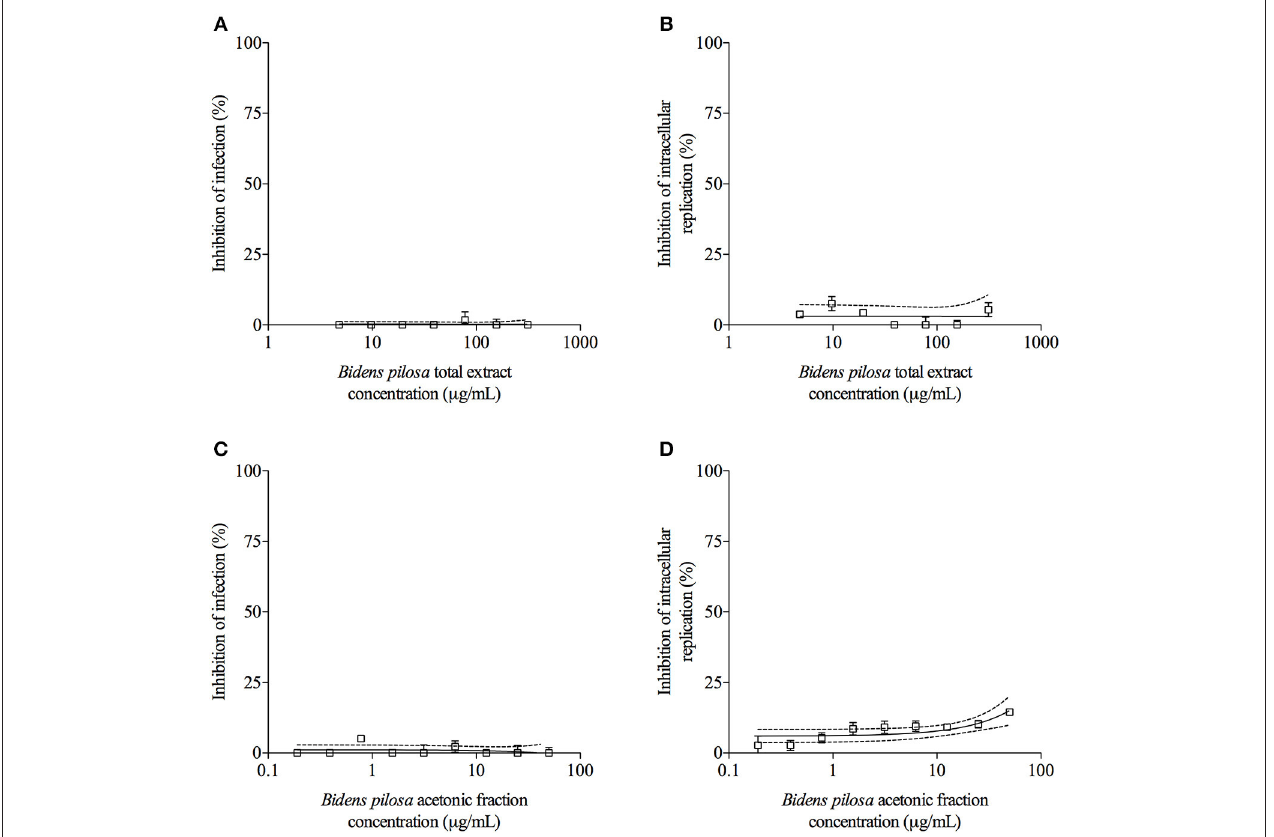
FIGURE 5 | Effects of treatment with B. pilosa on HeLa cells in T. gondii infection index and intracellular replication of the parasite. Treatments were carried out before T. gondii infection on HeLa cells with total extract (A,B) or acetonic fraction (C,D) of B. pilosa . Results are expressed as inhibition of percentage of infection (A,C) and parasite intracellular replication (B,D) in comparison to controls. Dotted lines show the inhibitory concentration of 50% (IC 50 ) and bars represent standard deviations. Values are representative from three independent experiments, indicating mean ±